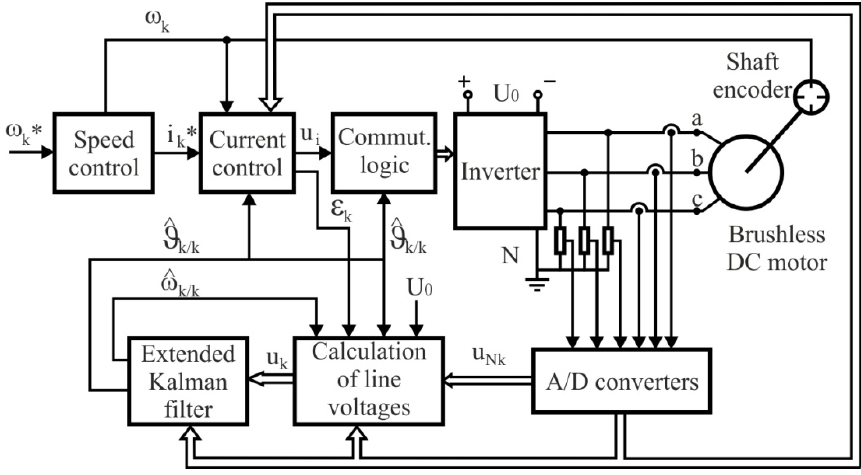
Figure 18. System configuration for speed and rotor position estimation of a BLDCM